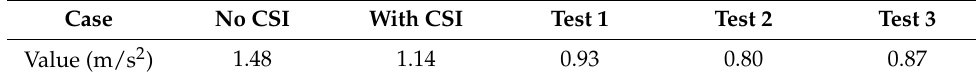
Table 4. Comparison of predicted and measured mid-span RMS acceleration.